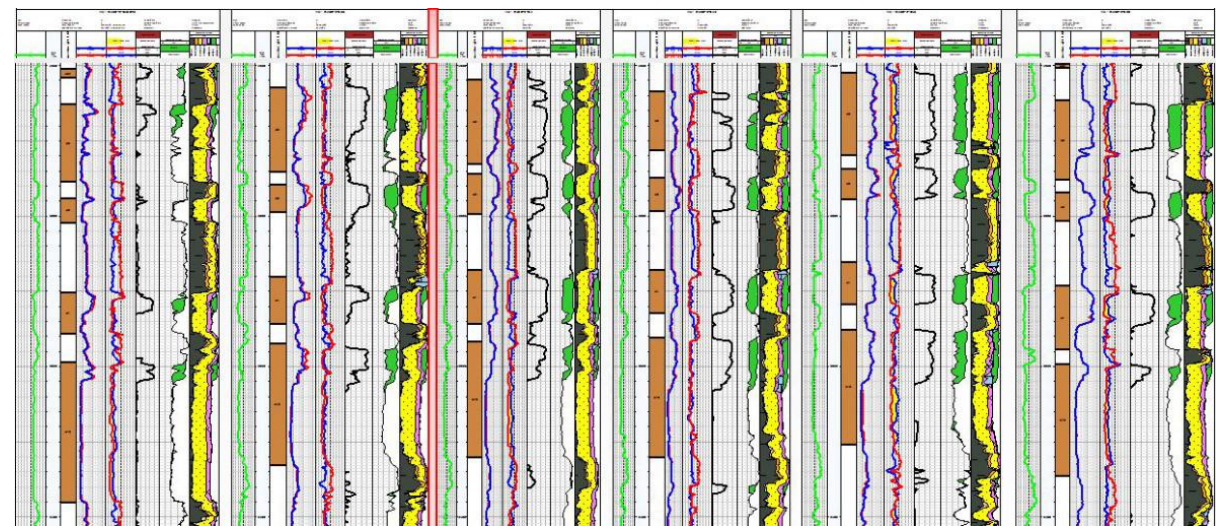
Fig. 12 Comparison of logging interpretation results after